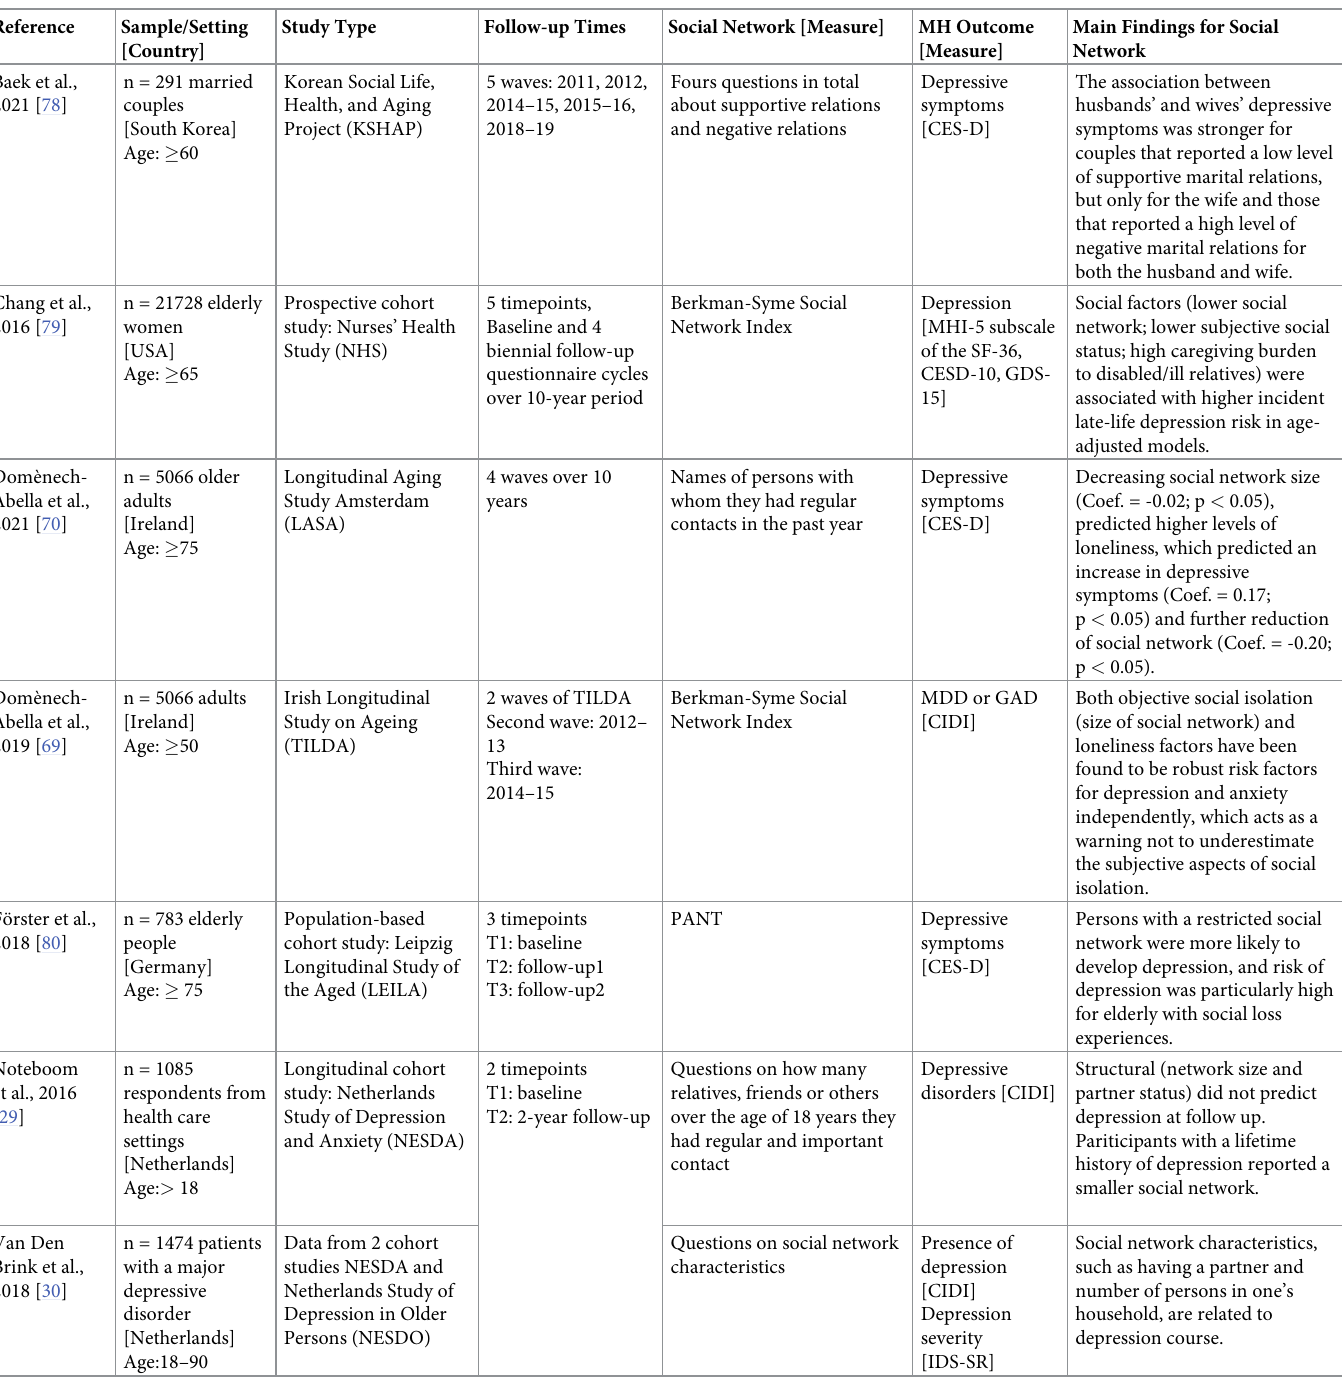
Table 3. Characteristics of included studies on social